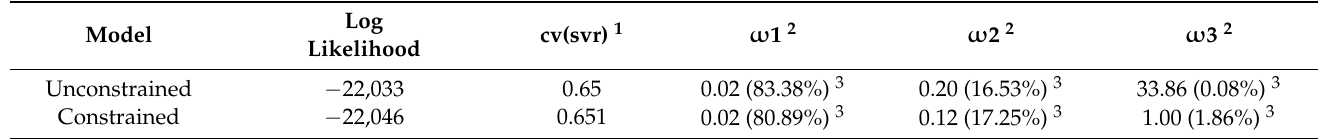
Table 2. Gene-wide evolutionary selection analysis of SLC25A44s across the vertebrate phylogeny.